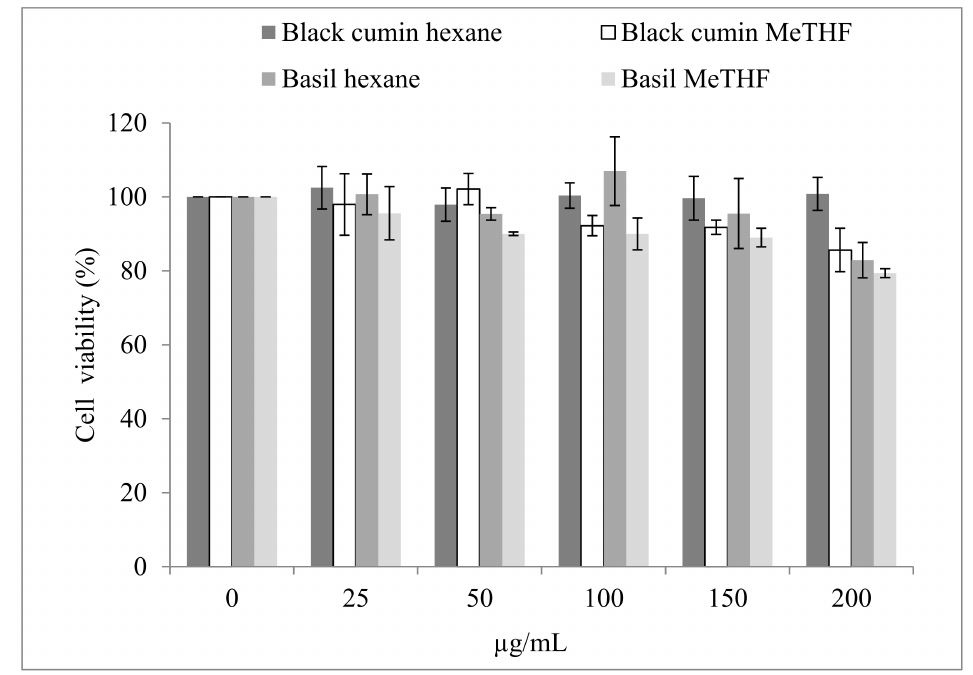
Figure 2. Effect of black cumin and basil oils at different concentrations (25–200 µ g/mL) obtained with conventional and green extractions on the viability of RAW 264.7 cells. Means ± SD, n =